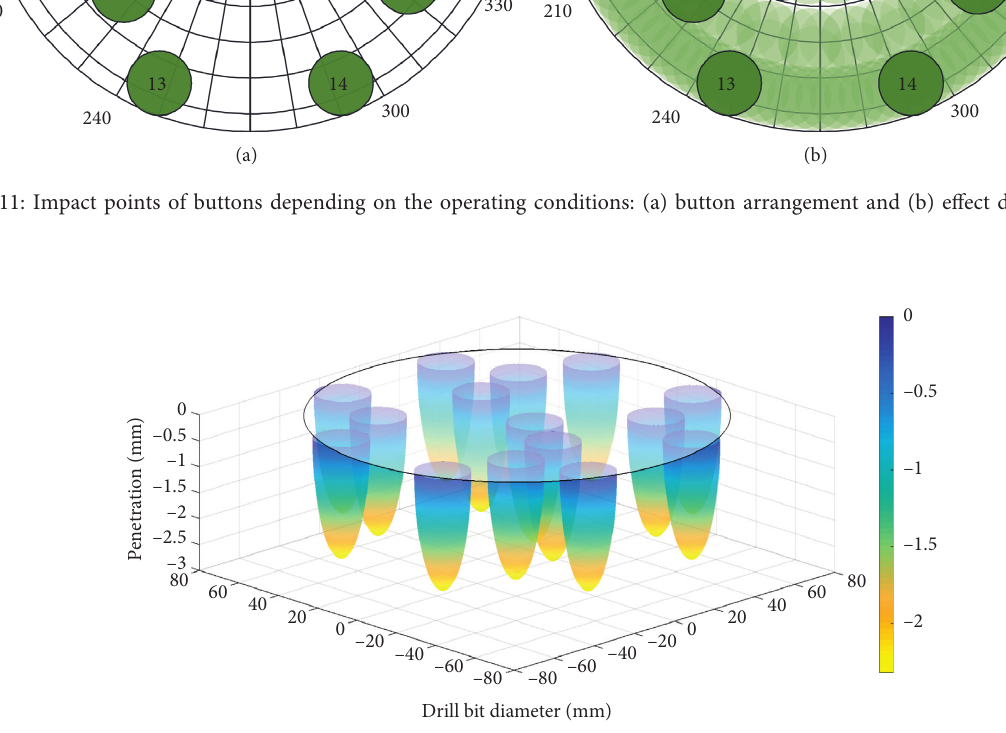
Figure 12: Drilled depth (h) and radius (r) of fractures in rock drilled with a button